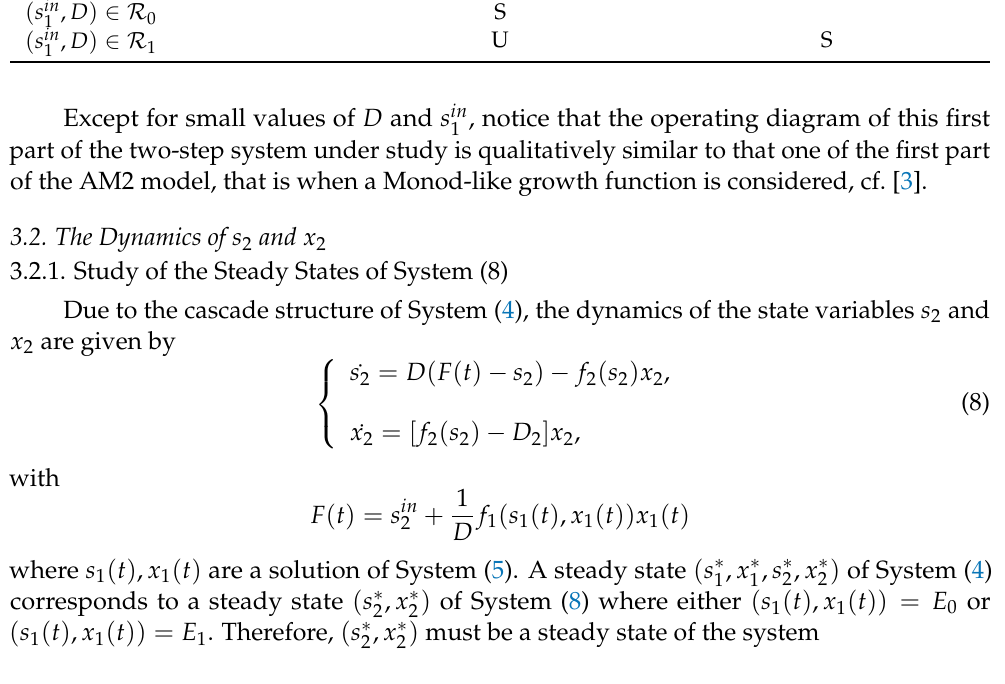
Table 2. Stability properties of steady states of system (5) in each region.